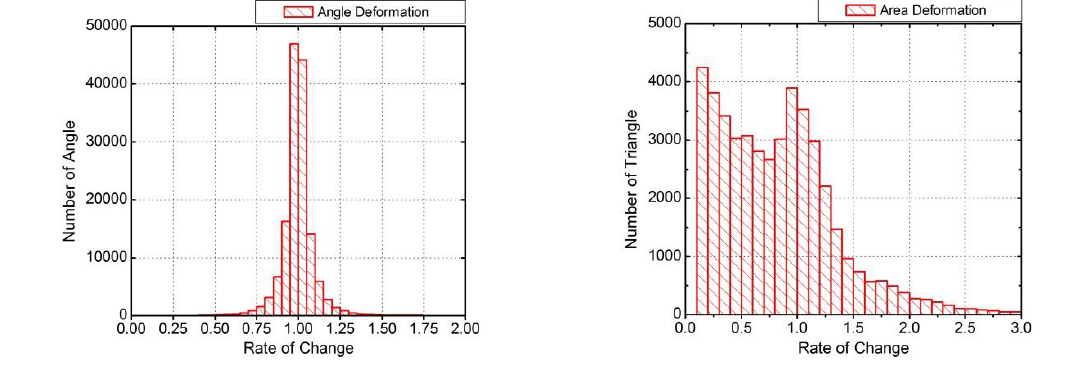
Fig.4. Angle (left) and area (right) deformations histograms